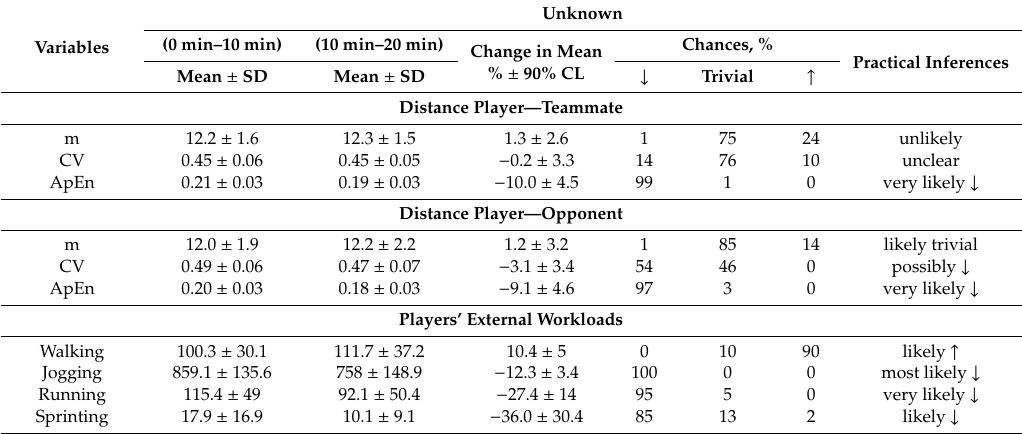
Table 1. Descriptive statistics when comparing (0 min–10 min) vs. (10 min–20 min) for the Unknown condition game variables.